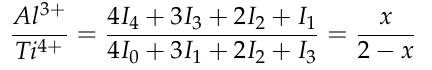
Figure 6. As a consequence of small dipolar and quadrupolar interactions, only central (CT) transitions of 6 Li MAS NMR spectra were detected. Each spectrum consisted of the signals located at − 1.4, − 0.9, − 0.7, − 0.4, and − 0.1 ppm. The resonances at − 0.9 and − 0.7 ppm may be assigned to Li1 and Li3 sites in the NASICON crystal structure [5,24,44]. The relative integrated intensity of the peak at − 0.7 ppm was much higher than for the − 0.9 ppm peak, in agreement with the preferential occupation of Li3 sites. The lines located at − 1.4, − 0.4, and − 0.1 ppm can be attributed to the lithium environment in LiAlP 2 O 7 , LiTiPO 5 , and in the unidentified phase, respectively [24]. Referring to relative signal intensities, one may deduce that the concentration of lithium ions in the NASICON-type phase was about 88%. The relative integrated intensities of the signals remained the same regardless of the sintering temperature and time.